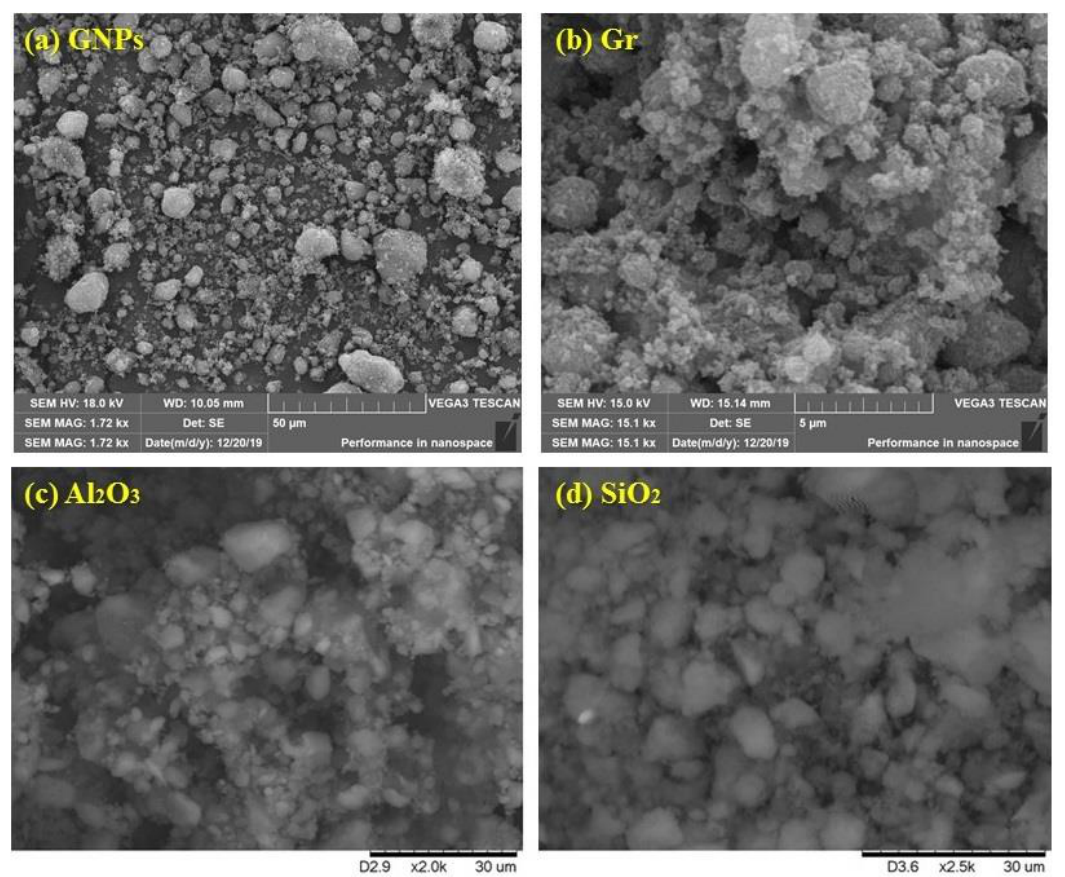
Figure 3. Visualization of different SEM nanoparticles; ( a ) Graphene nanoplatelets, ( b ) Graphene, ( c ) Alumina, ( d ) Silica.